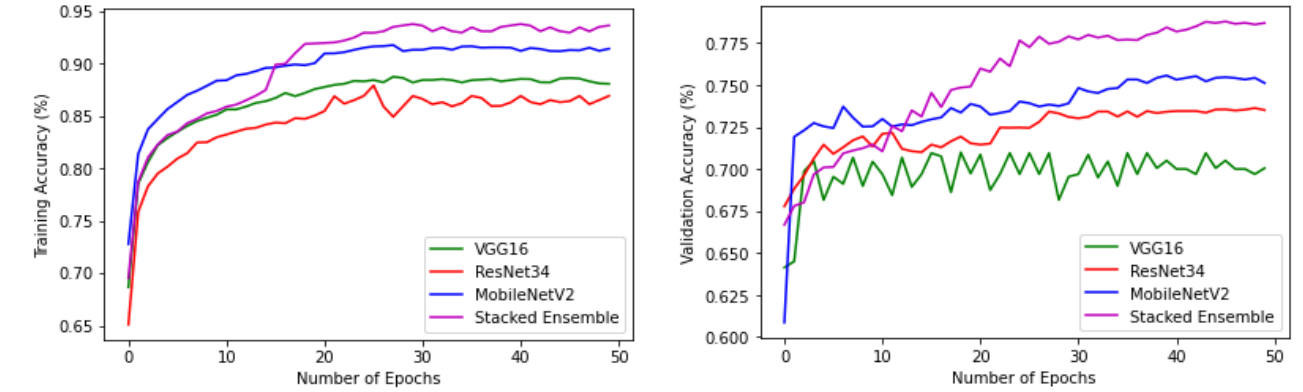
Figure 9. Training and validation accuracy of base-learners with VGG16, Resnet34, MobilenetV2, and Ensemble models, respectively.